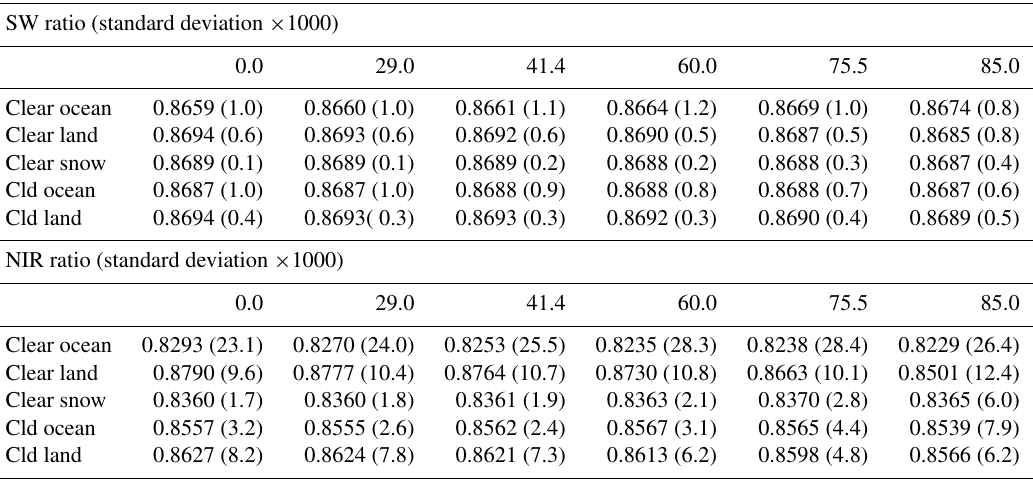
Table 2. Mean ratio and standard deviation (in parenthesis) of filtered radiance to unfiltered radiance for SW and NIR bands over different scene